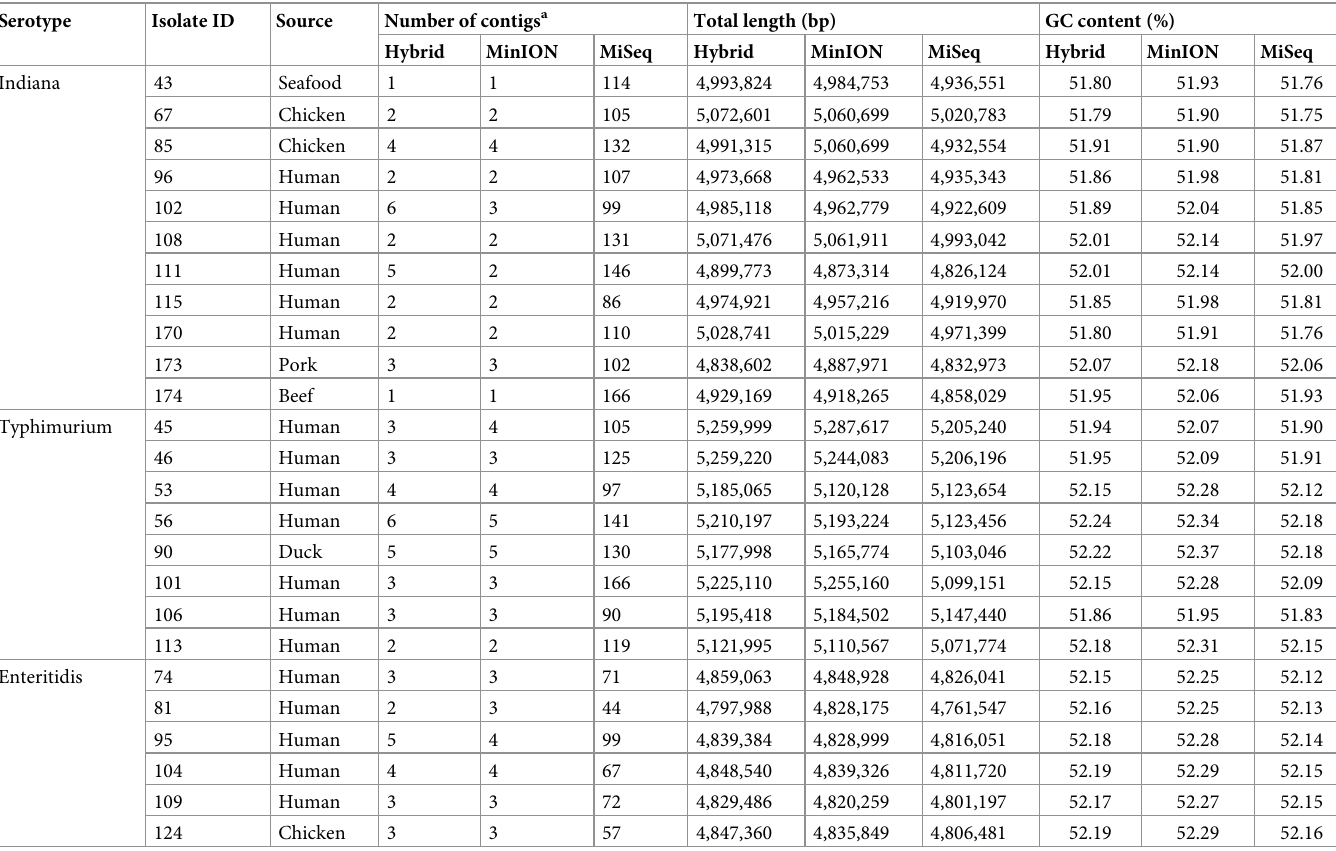
Table 1. The hybrid, MinION, and MiSeq assemblies of Salmonella